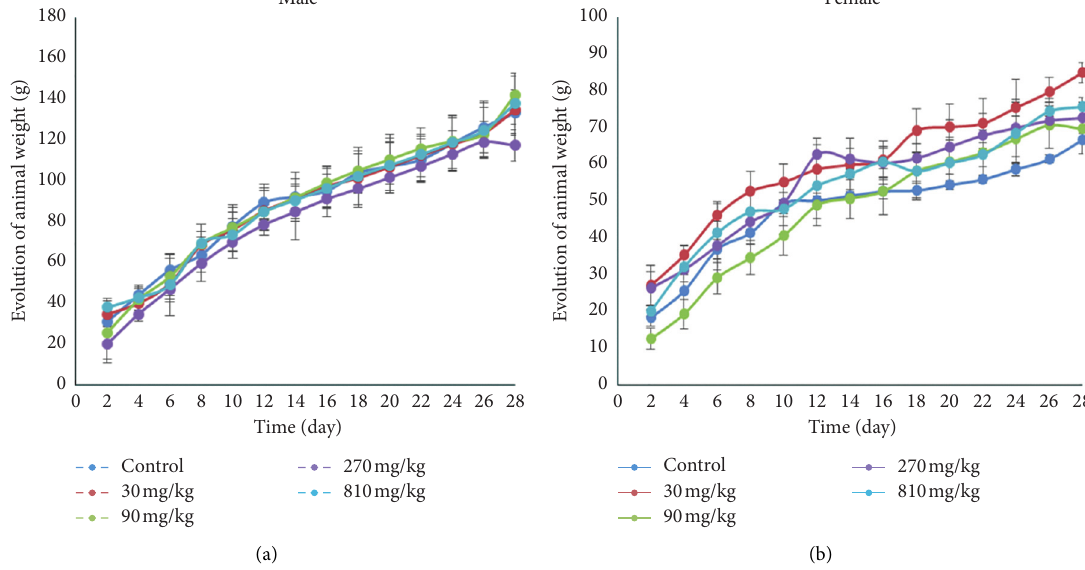
Figure 3: Effect of subchronic administration of aqueous extract of T. grandis on body weight of rats. Data are expressed as mean ± SD, n � 4. Values for a given group in a column followed by a different letter as superscript are significantly different according to Waller–Duncan’s multiple comparison test ( p < 0.05). (a) Males. (b) Females.